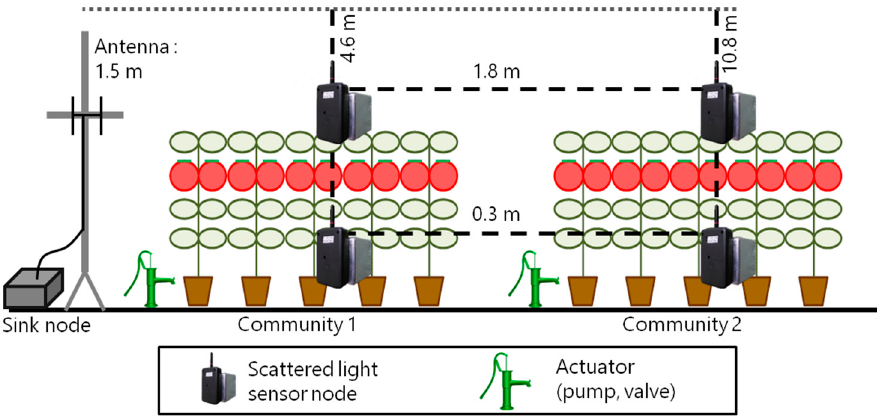
Figure 11. RSSI variation and packet loss with or without plants: ( a ) 2.4 GHz band; ( b ) 400 MHz band.